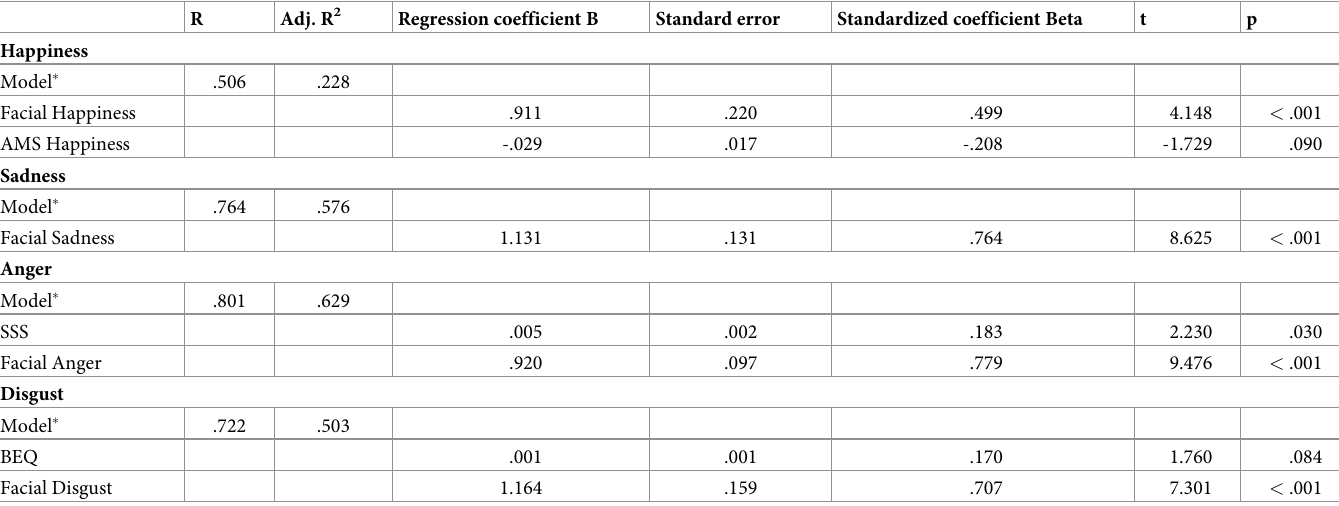
Table 3. Regression model for facial expressions after corresponding emotion